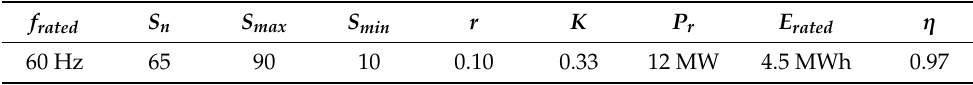
Table 1. Default parameters for energy storage systems (ESS)-FR.